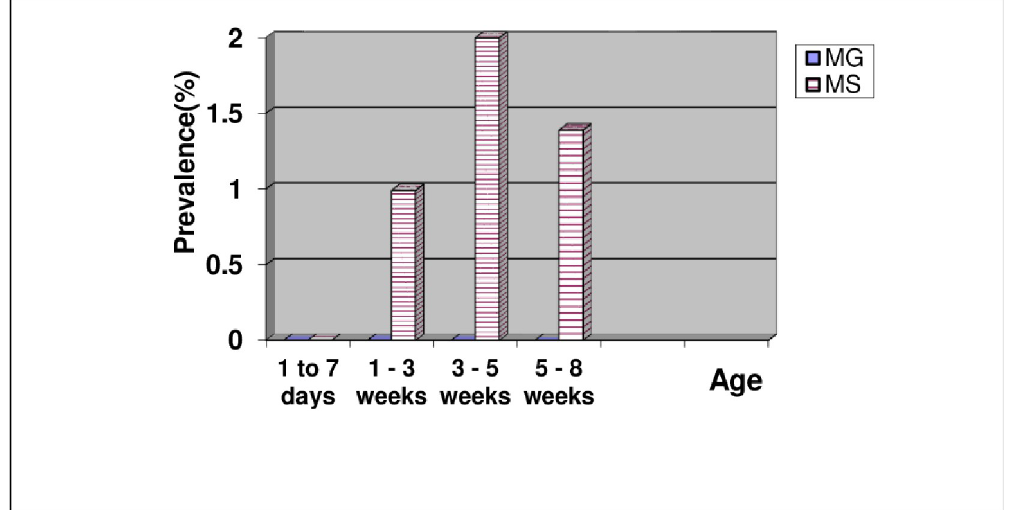
Fig 2. Age-related prevalence of mycoplasmosis in Ross broiler chickens by slide plate agglutination test.